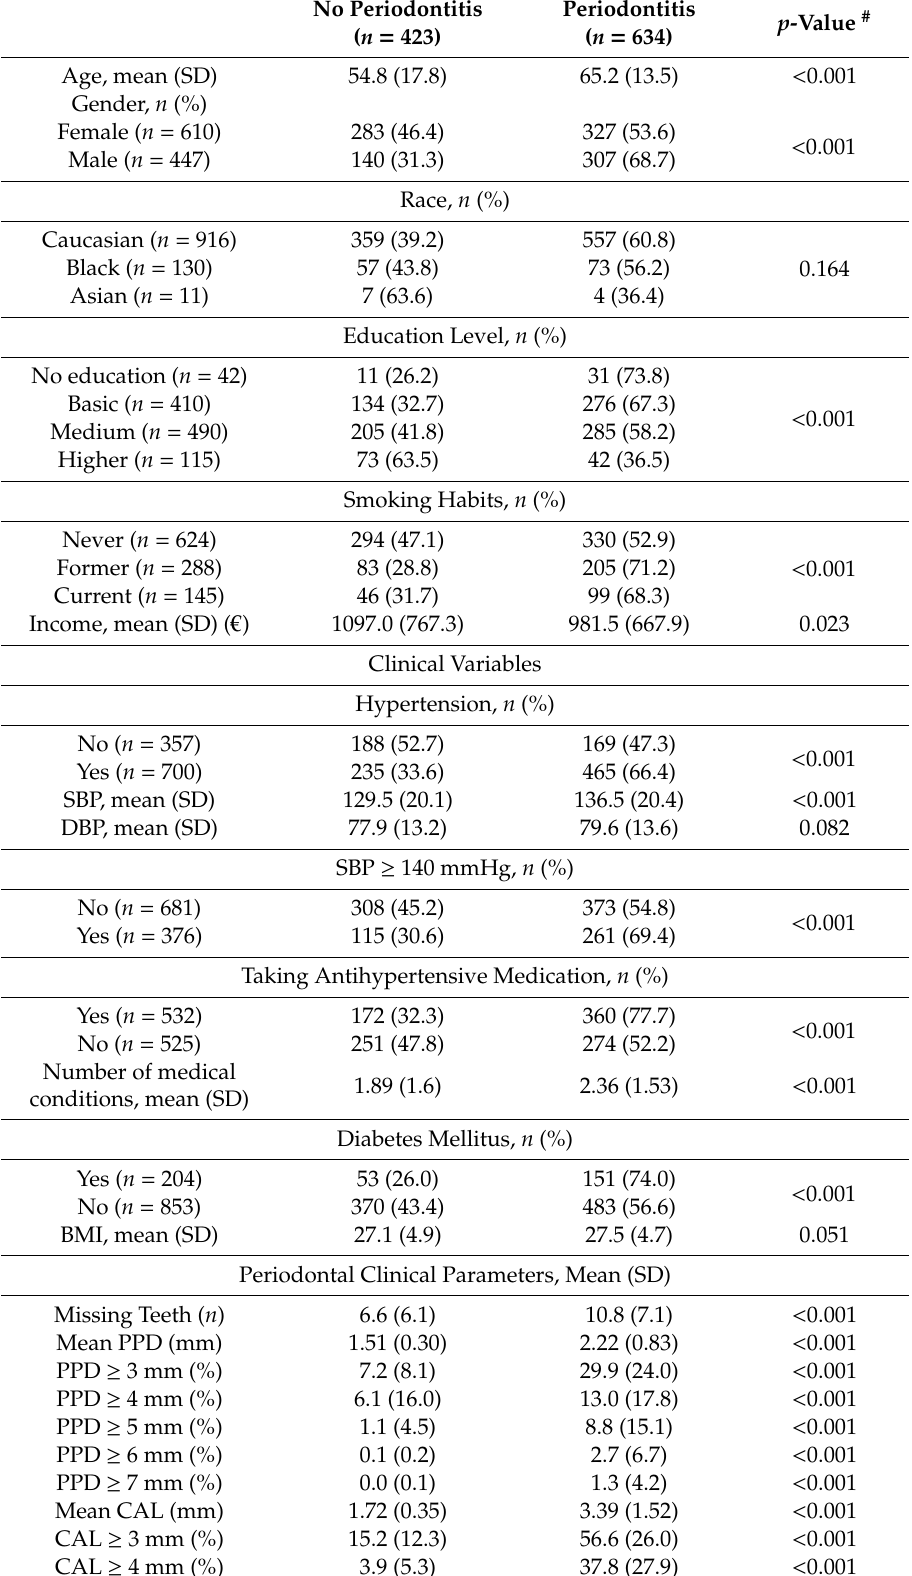
Table 1. Baseline characteristics of participants according to periodontal status ( n =